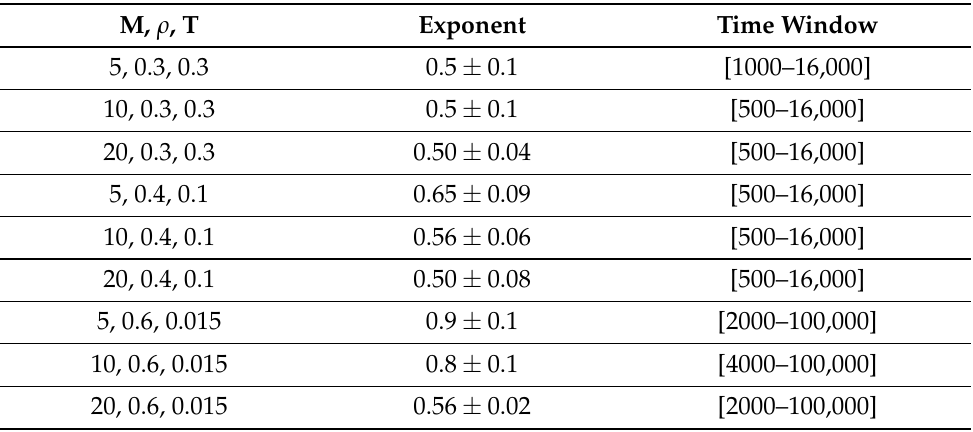
Table 1. Exponent of the power-law regime in domain growth, and the corresponding time interval in which the exponent is determined, for different states obtained while varying chain length M , density ρ and quench temperature T .